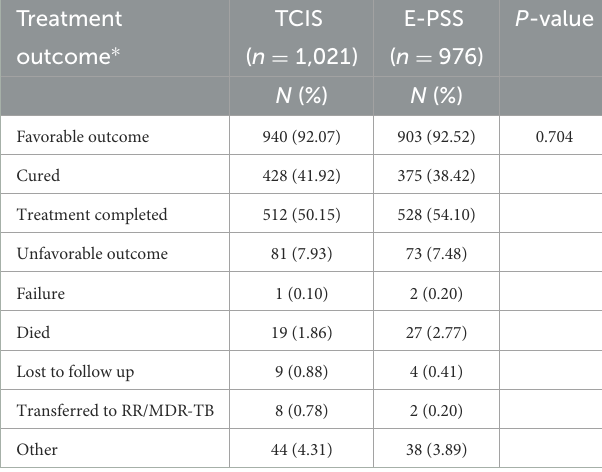
TABLE 3 Treatment outcomes among patients with TB recorded in TCIS and e-PSS during 2020–2021 in Wuhan, China.